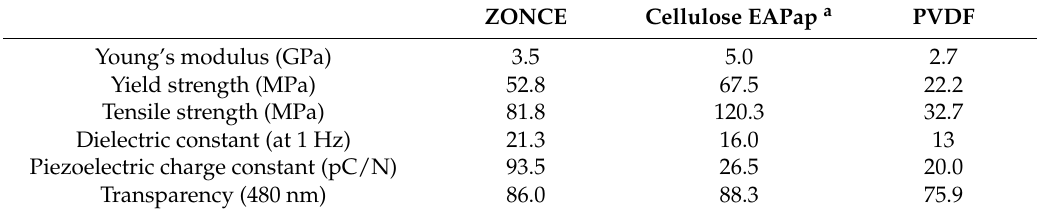
Table 6. Comparison of mechanical, electrical and piezoelectric properties of cellulose EAPap, zinc oxide nanocoated cellulose film (ZONCE), and polyvinylidene fluoride (PVDF) [27]. ZONCE Cellulose EAPap a ZONCE